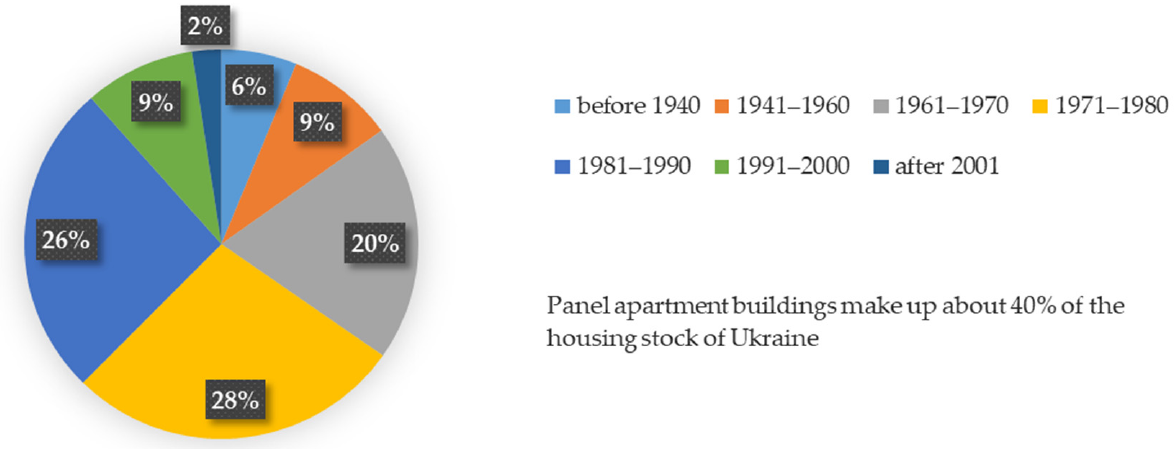
Figure 3. The housing stock (apartment buildings) of Ukraine is distributed by years of construction. The most widespread large-panel buildings in the territory of Ukraine are